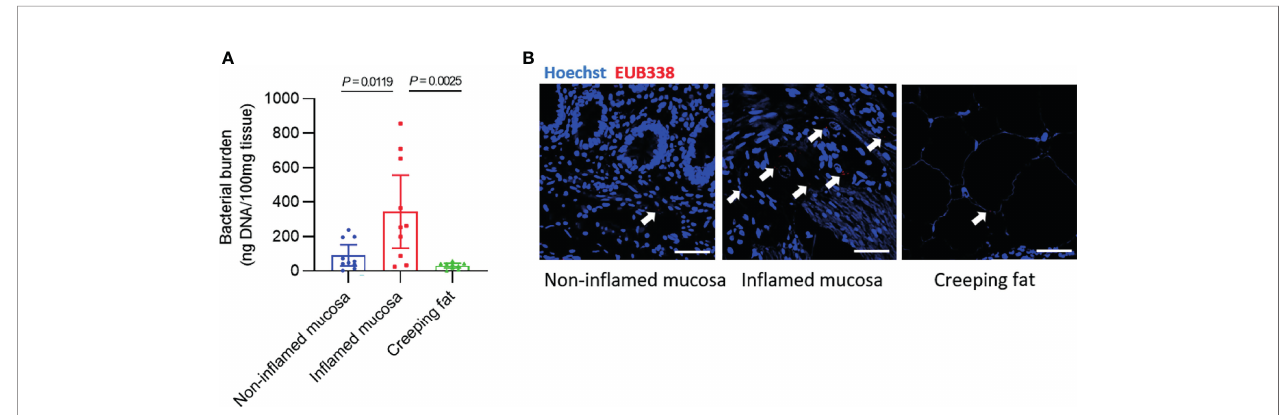
FIGURE 1 | Detection of bacterial burden in different intestinal tissues. (A) The concentration of bacterial DNA extracted from every 100 mg of intestinal tissue. (B) Fluorescence in situ hybridisation (FISH) with an oligonucleotide probe against general bacteria (EUB338) was used to examine the number and spatial distribution of intact bacteria within nonin fl amed mucosa, in fl amed mucosa, or creeping fat sections from CD patients: EUB338 (red) and DNA (blue). Scale bar, 100 m m. Data are presented as the mean ± 95% CI; p -value calculated by one-way ANOVA with Tukey ’ s multiple comparisons test.